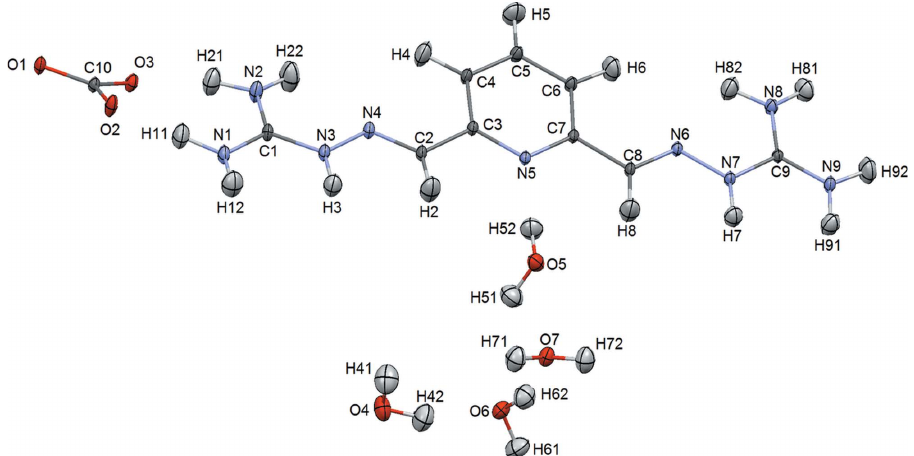
Figure 1 The asymmetric unit of PyBIG carbonate tetrahydrate, as determined from 100 K neutron diffraction data, showing the atom numbering. Displacement ellipsoids are at the 50% probability level (Macrae et al. ,